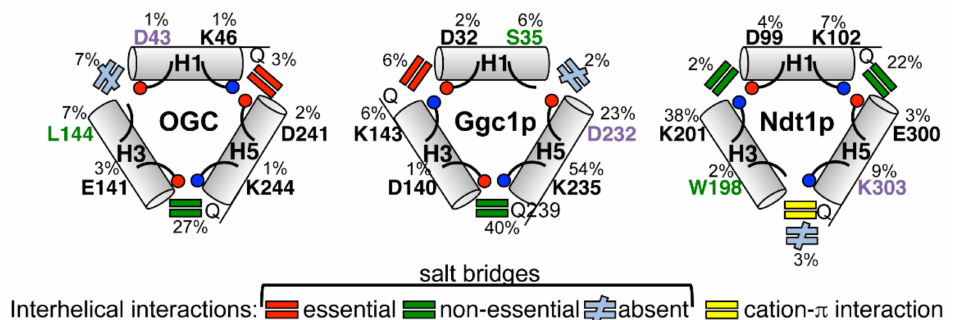
Figure 5. Schematic presentation of the M-gate salt bridge networks of OGC, Ggc1p, and Ndt1p. The positive and negative charges of the PX[DE]XX[KR] motifs are indicated by blue and red circles, respectively. Non-charged residues are in green and unpaired charges are in violet. Glutamines potentially forming glutamine braces of the salt bridge in proximity to the charged residues are indicated with